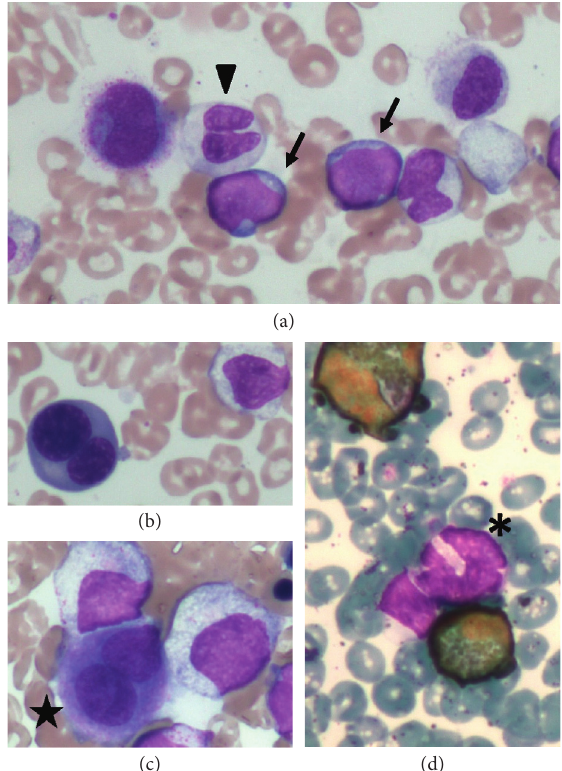
Figure 1: Microscopic findings of the bone marrow smears. Bone marrow aspirate smears (May–Giemsa staining; magnification: × 400) showed (a) myeloblasts (arrows) and a hyposegmented mature neutrophil (arrowhead), (b) a binucleated erythroblast, and (c) a micromegakaryocyte (indicated with a star). (d) Myeloperoxidase staining (magnification: × 400) of the bone marrow cells showed a hypogranular neutrophil (indicated with an asterisk).